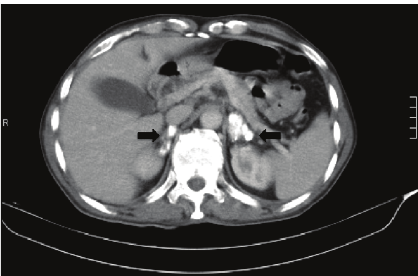
Figure2: Abdominal tomographyrevealedbilateral calcificationsof both adrenal